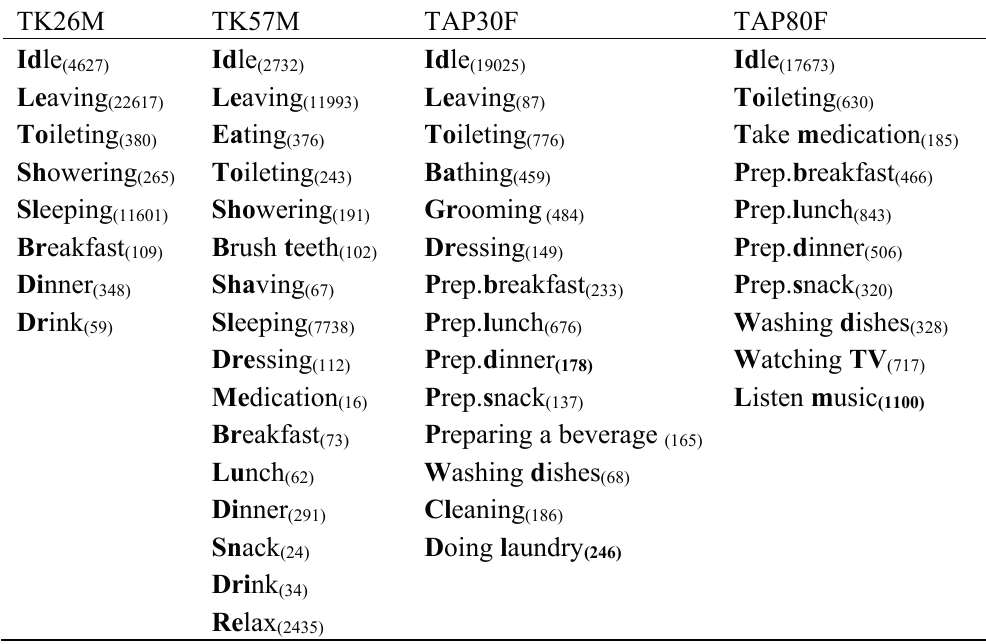
Table 2. Annotated list of activities for each house and the number of observations of each activity. The bold letters represent each